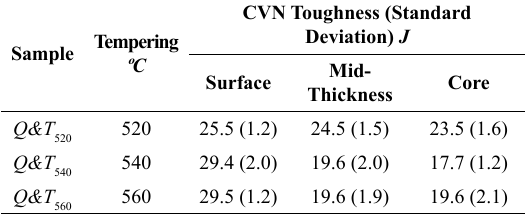
Table 3. CVN toughness results for samples which were not submitted to solution treatment. Average and standard deviation for 3 specimens.